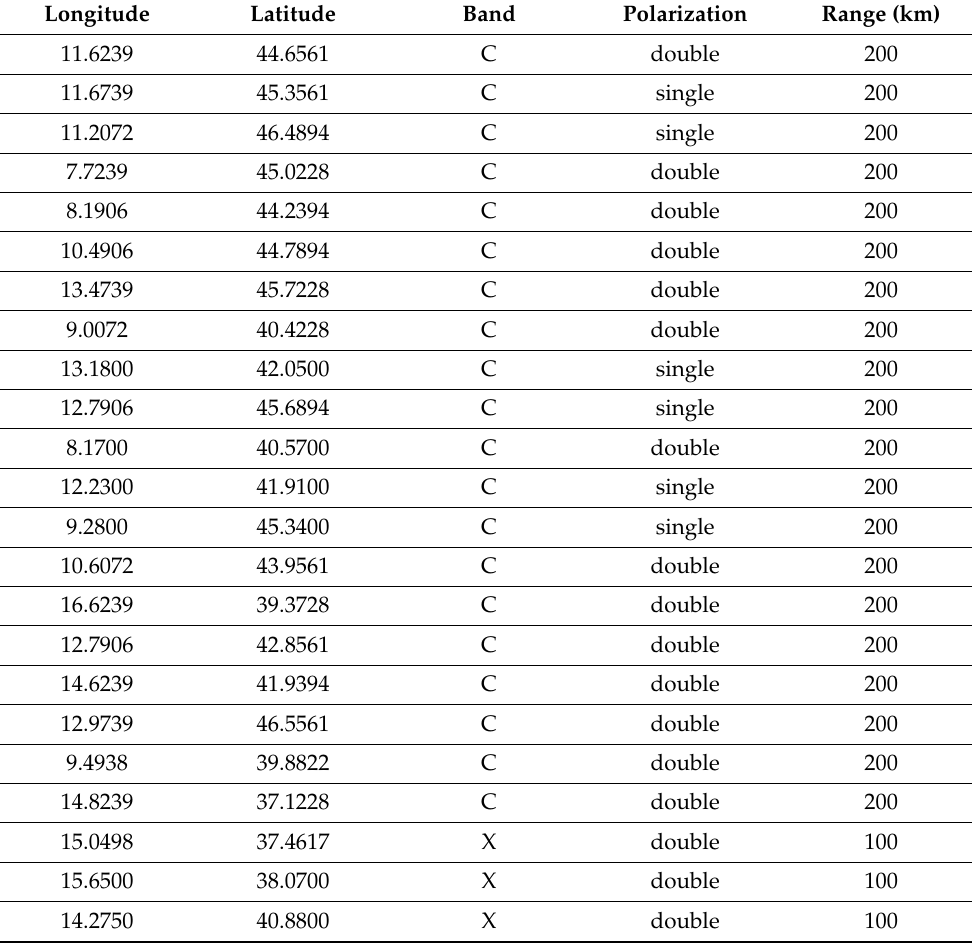
Table 1. Characteristics of radars composing the Italian radar